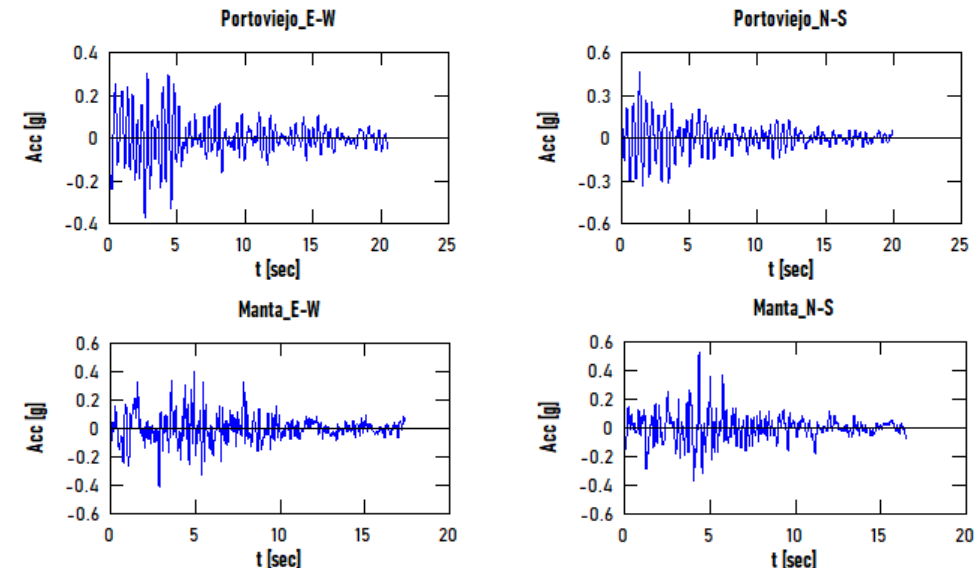
Figure 11. Acceleration records from the four stations reported.